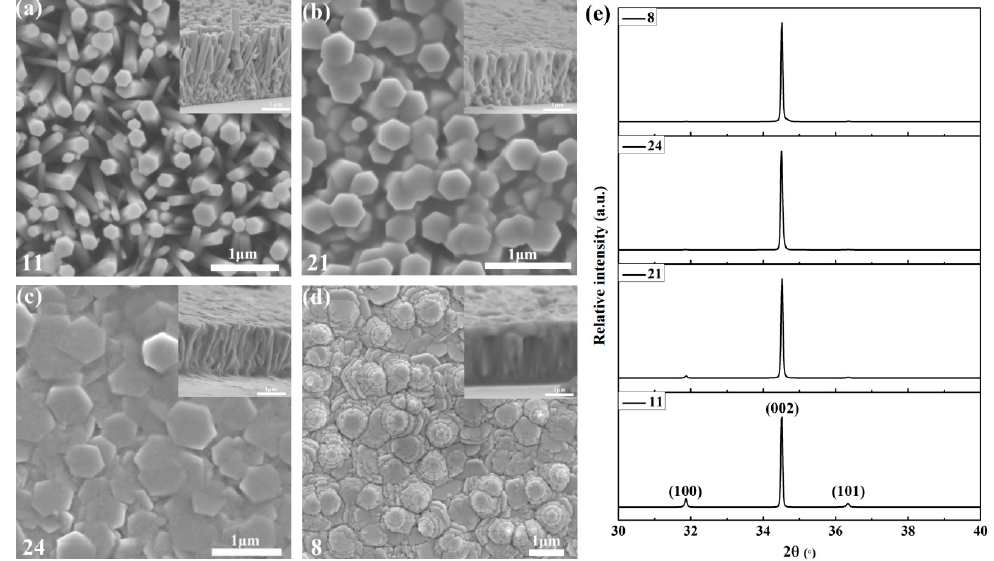
Figure 8. Typical SEM images ( a – d ) and XRD patterns ( e ) of the obtained ZnO rod arrays. The insets in the SEM images are the corresponding cross-section images of ZnO nanorod arrays, and